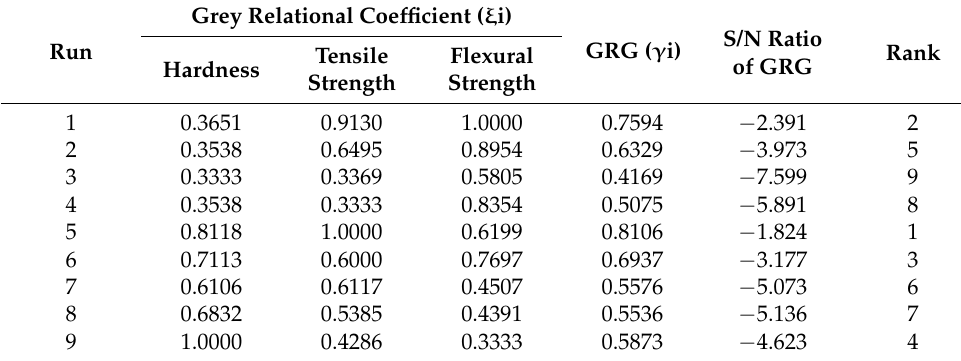
Table 9. Grey relational grade (GRG) rank.